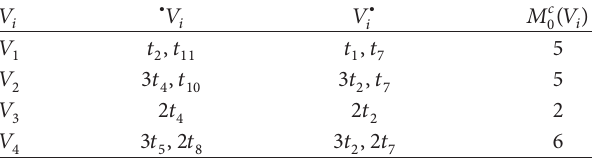
Table 1: Monitors 𝑉 𝑖 added for the net shown in Figure 1(a).